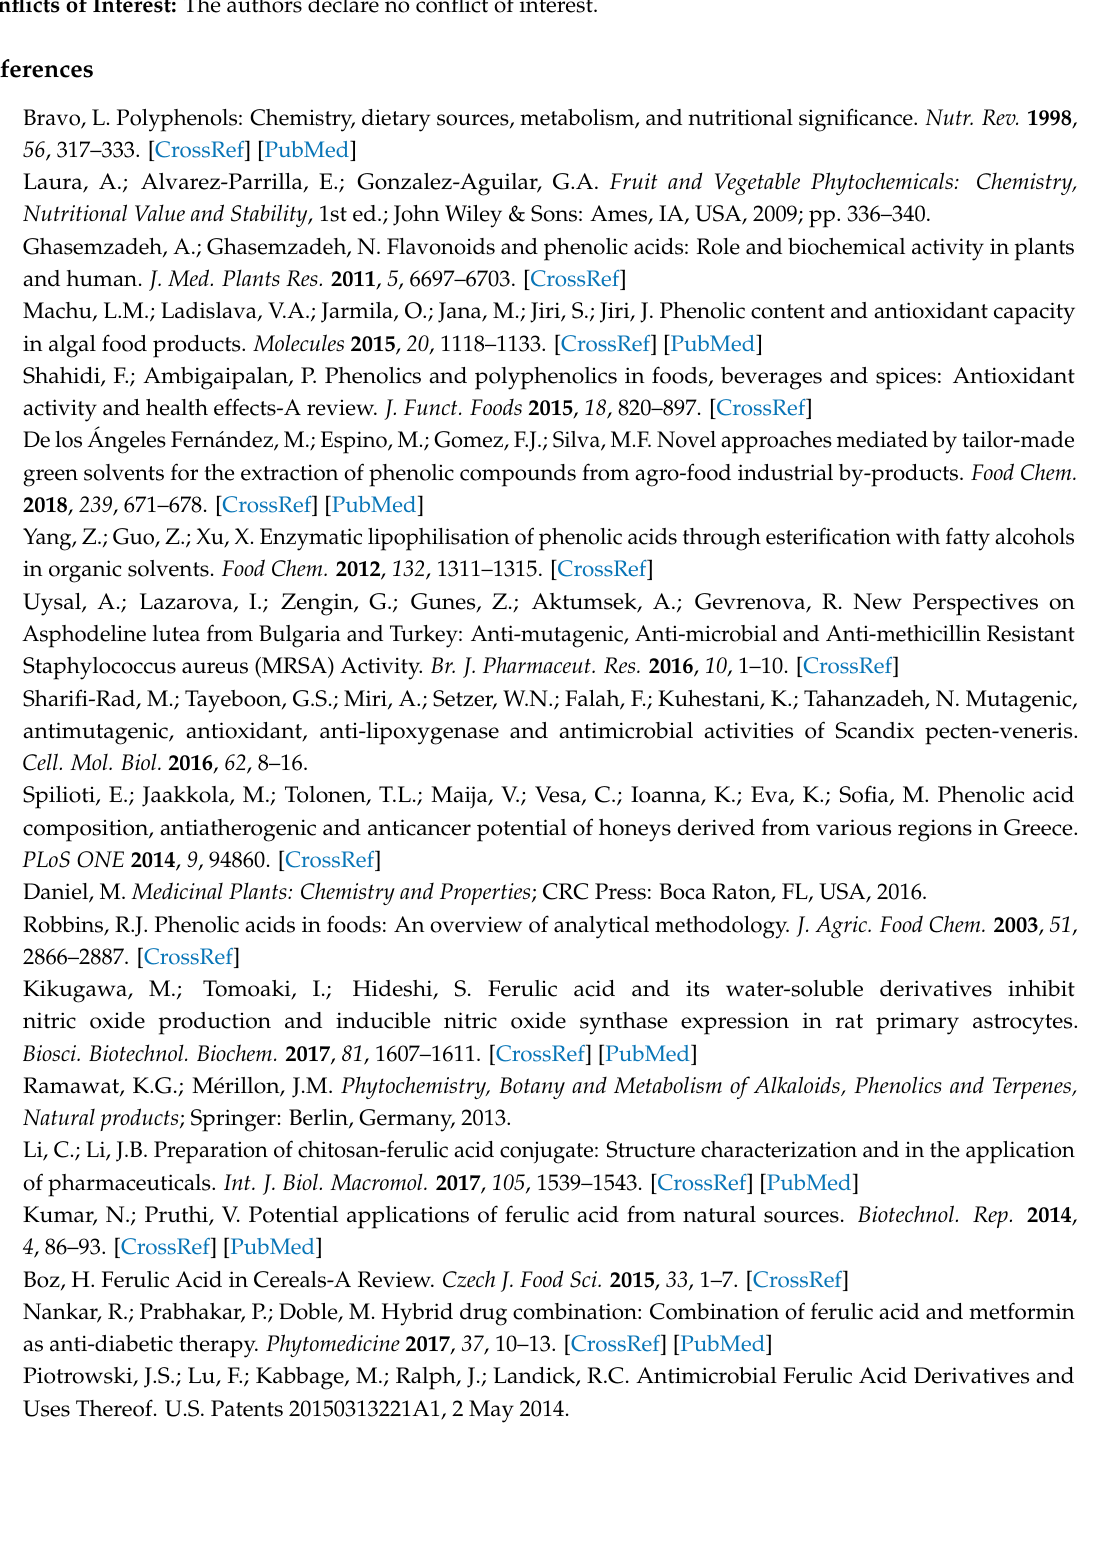
Supplementary Materials: Figures S1–S6: Extrapolation graph for EC 50 of FA and synthesized PILs, Figures S7–S12: Extrapolation graph for TEC 50 of FA and synthesized